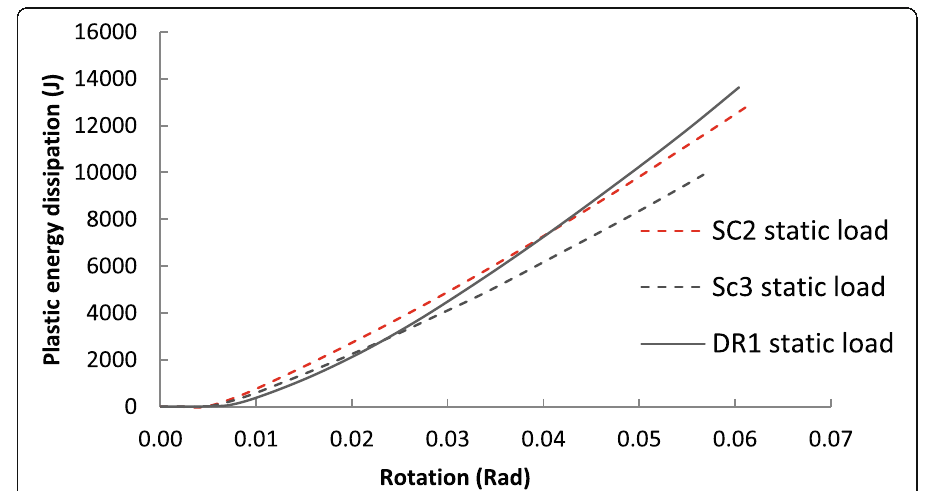
Fig. 30 Plastic energy dissipation for connections SC2, SC3, and DR1 under static loading